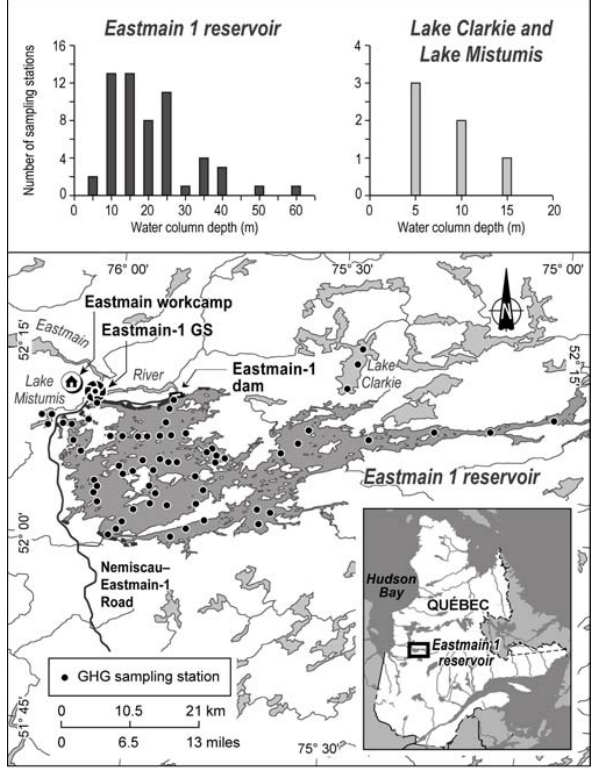
Figure 1. Map of sampling stations in Eastmain River watershed; graphs representing distribution of sampling depths.